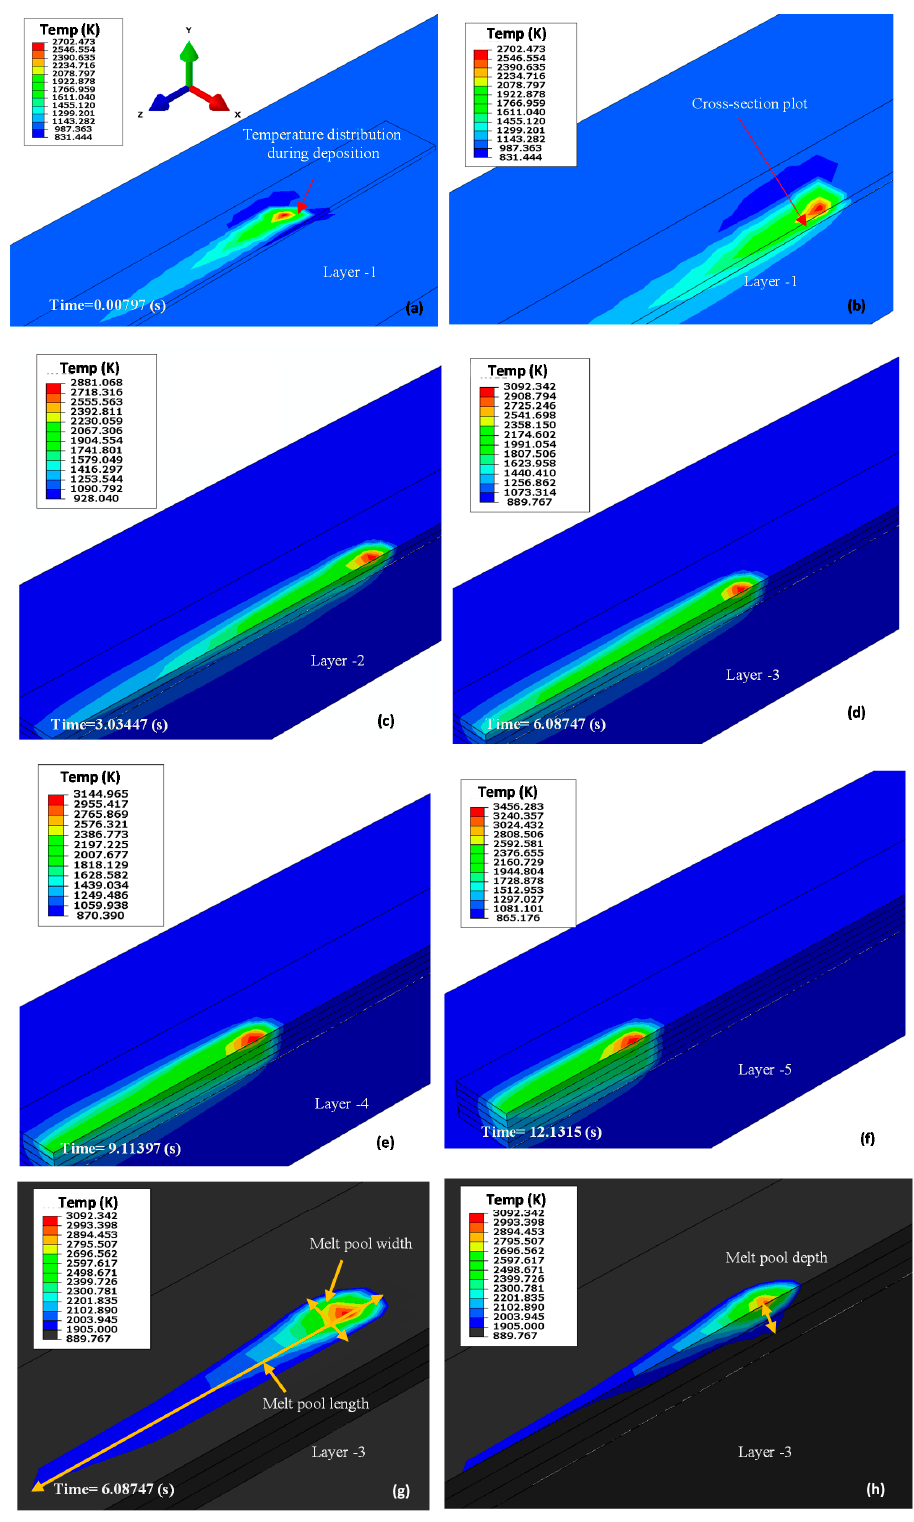
Figure 10. Contour and cross-section plots of temperature field of the melt pool and surrounding areas at different times: ( a ) Layer-1 (contour plot), ( b ) Layer-1 (cross-section plot), ( c ) Layer-2 (cross-section plot), ( d ) Layer-3 (cross-section plot), ( e ) Layer-4 (cross-section plot), ( f ) Layer-5 (cross-section plot), ( g ) Layer-3 (melt pool contour plot), and ( h ) Layer-3 (melt pool cross-section) .